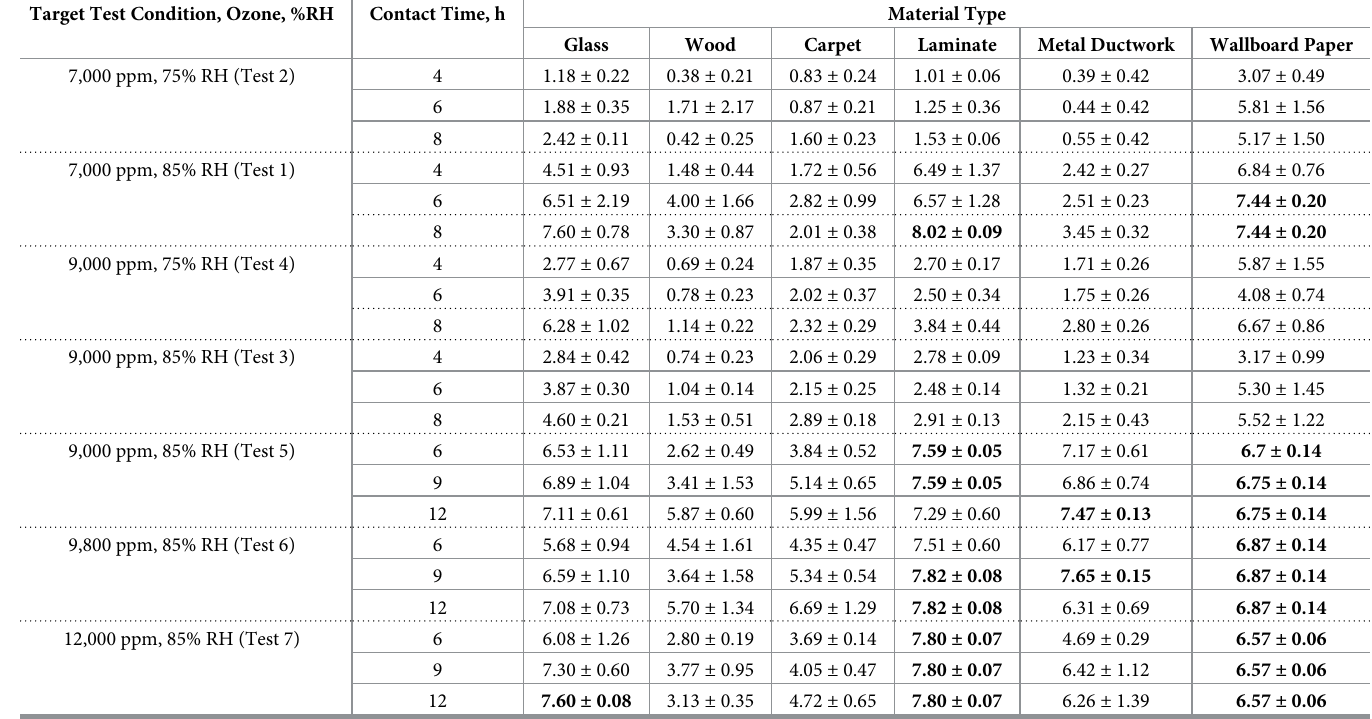
Table 7. Inactivation (Log reduction) of B . subtilis . Target Test Condition, Ozone,